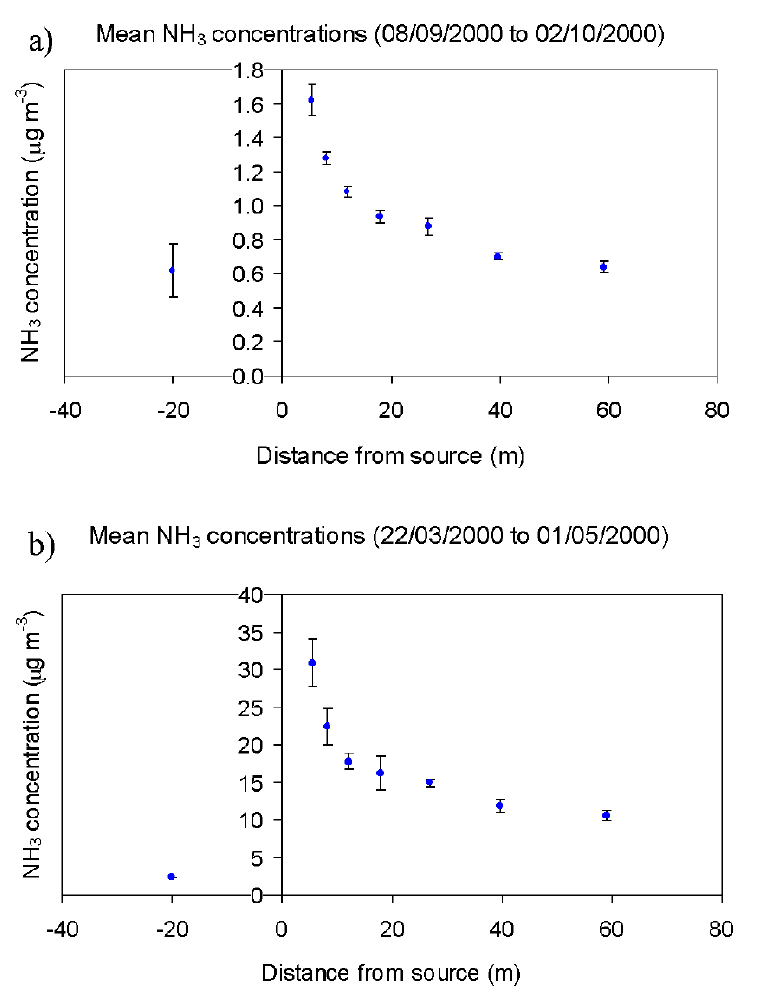
FIGURE 3. Example mean ammonia concentration measured by ALPHA samplers, at a height of 1.5 m, as a function of distance from the source. Error bars are ± 1 standard error of triplicate measurements at each